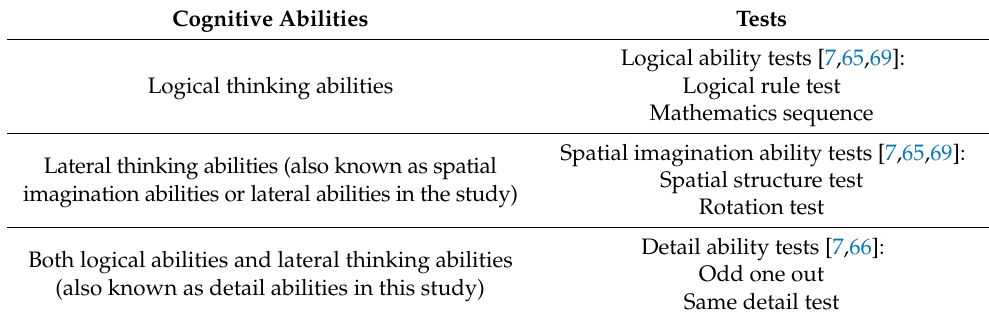
Table 1. Functions of six types of psychometric tests used in the